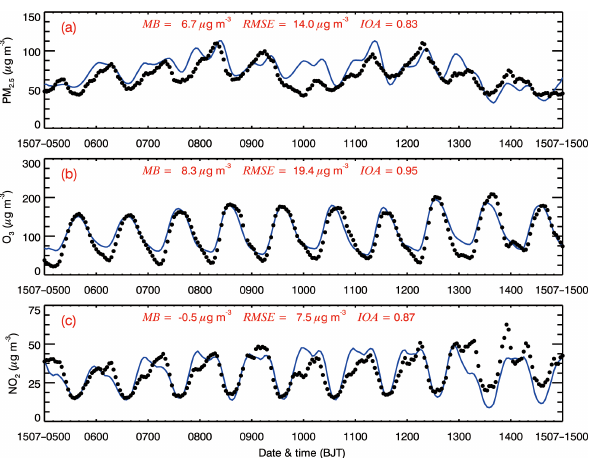
Figure 5. Comparison of measured (black dots) and predicted (blue line) diurnal profiles of near-surface hourly (a) PM 2 . 5 , (b) O 3 , and (c) NO 2 averaged over all ambient monitoring stations in BTH from 5 to 14 July